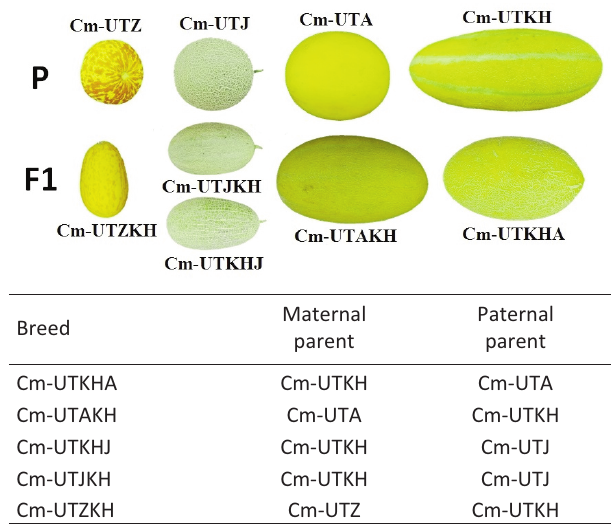
Fig. 1 ­ The studied melon inbred lines (P) and their hybrids (F1). The first part in each hybrid name represents the mater­ nal parent while the second represent the male